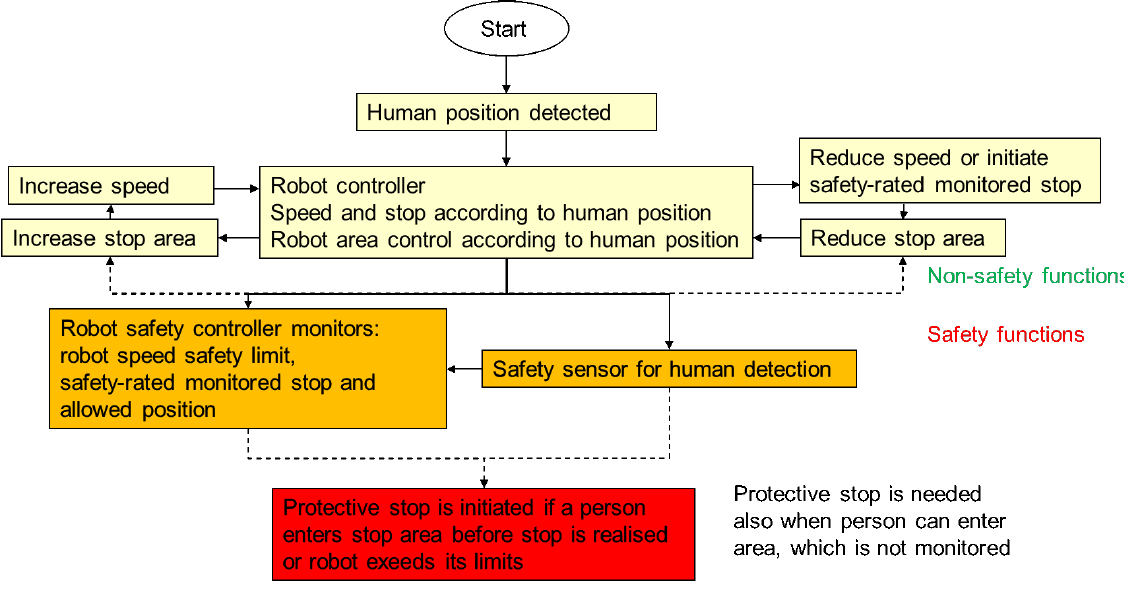
Figure 3: The process how speed is reduced and safety-rated monitored stop applied before protective stop is triggered, if necessary.